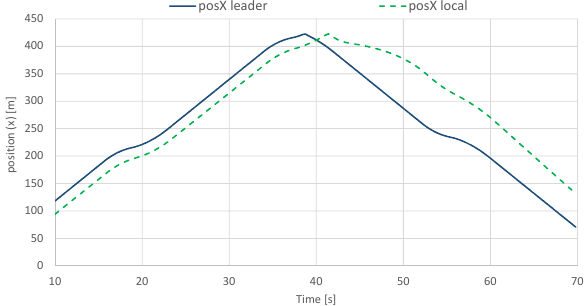
Figure 9: Speed of the leading vehicle and CACC controlled local vehicle with and without